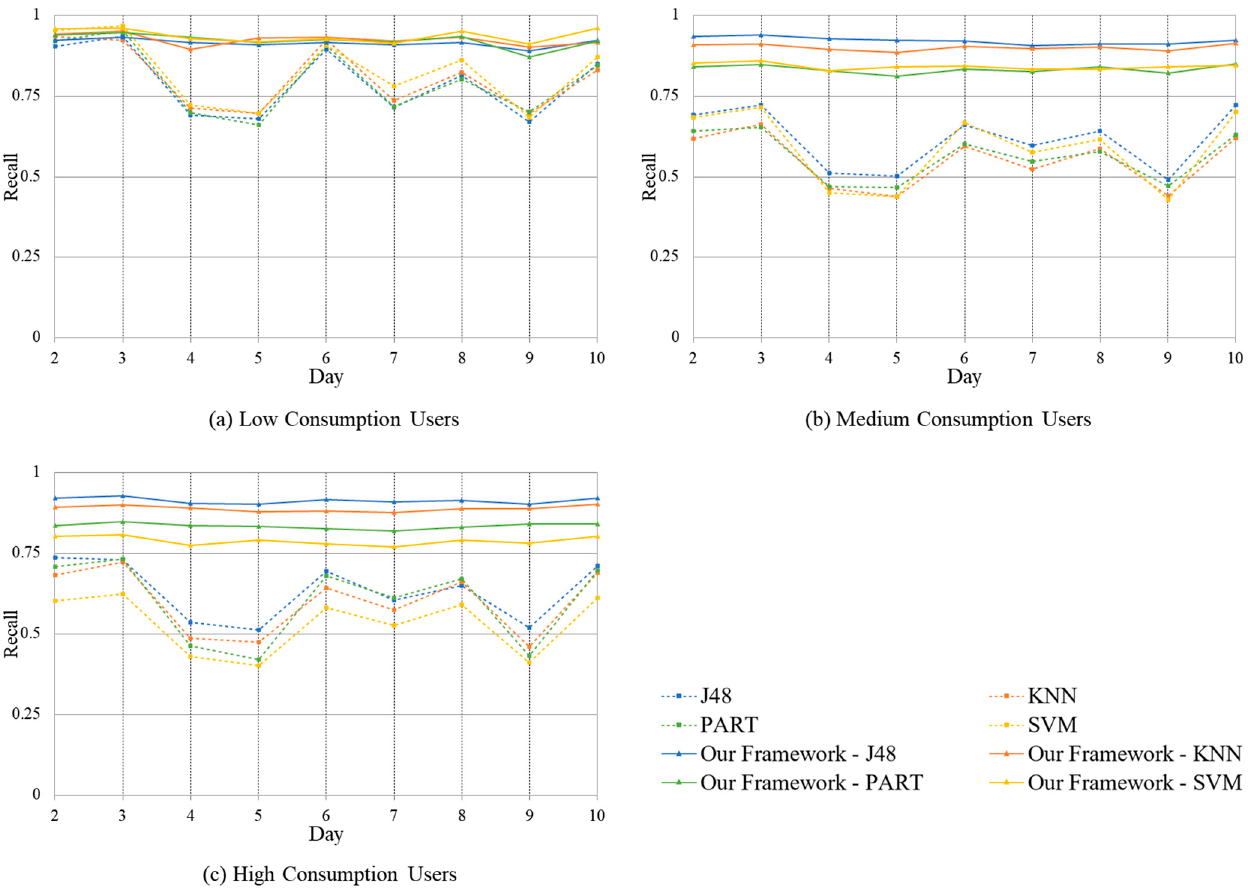
Figure 3. Change of recall on each for each user group: ( a ) low consumption users; ( b ) medium consumption users; ( c ) high consumption users.